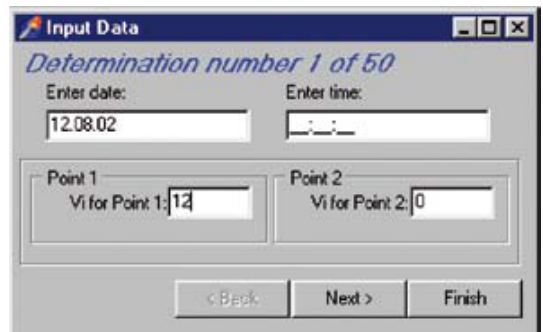
fig. 3. Dependence between the error and the total duration of trials